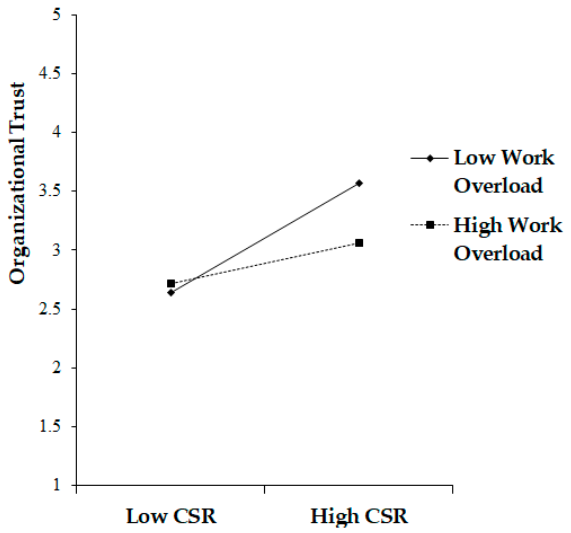
Figure 3. Moderating effect of work overload in the CSR–organizational trust link .